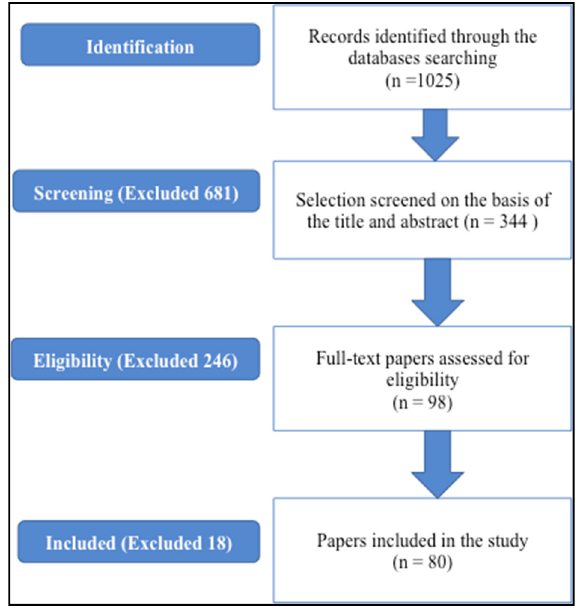
Figure 1. Flow diagram of the literature selection process for the systematic review.